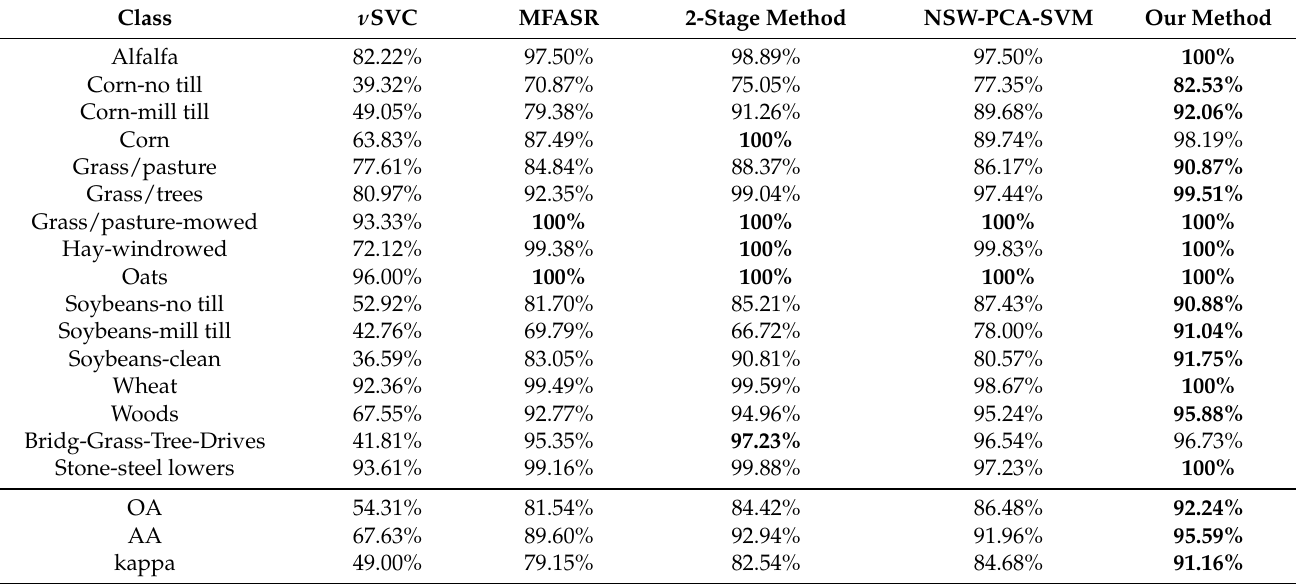
Table 1. Average classification accuracies over 10 trials for the Indian Pines dataset with 10 random training pixels for each class. The boldface font represents the highest accuracy among the